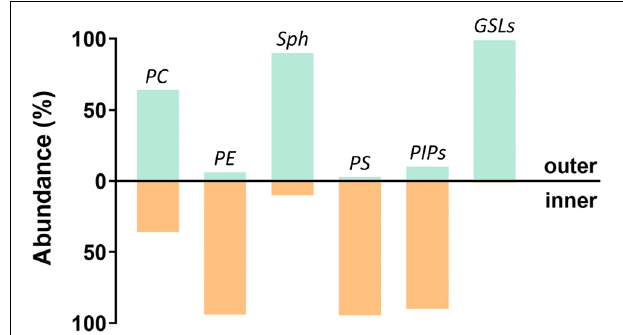
FIGURE 6 | Plasma membrane asymmetry. Schematic representation of the plasma membrane lipid composition. Distribution in both leaflets is depicted as a percentage of the total lipid class. Based on (Zachowski, 1993; Lingwood, 2011; Fujimoto and Parmryd,